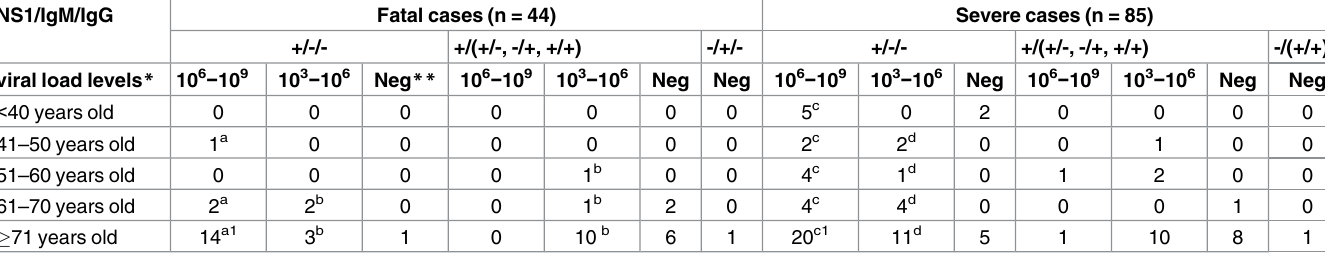
Table 4. Comparison of age groups between various NS1 antigen/IgM/IgG and viral load categories among fatal and severe cases.